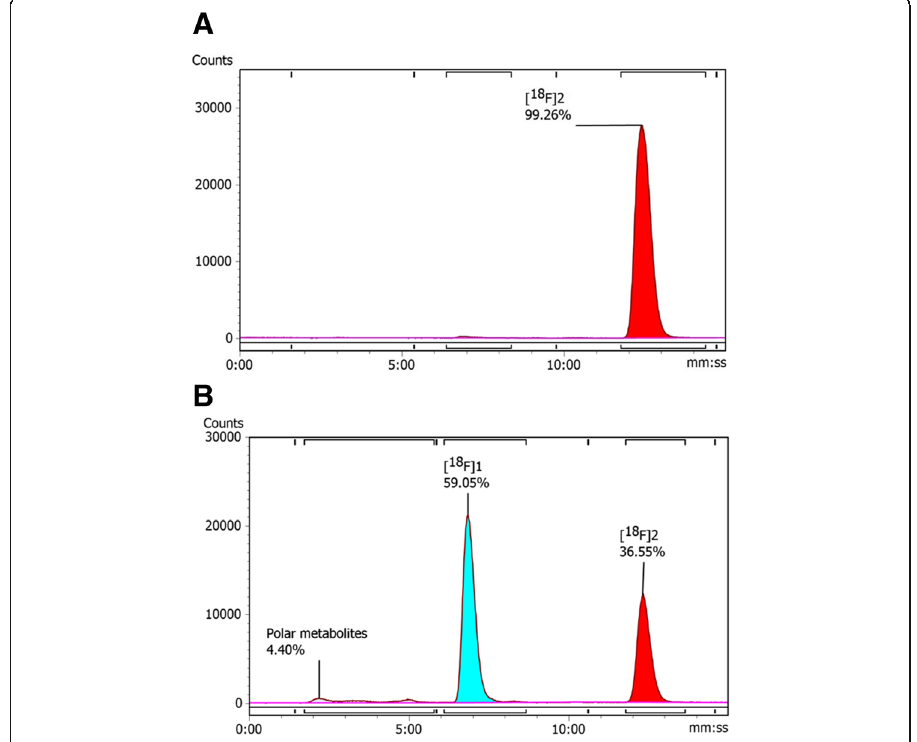
Fig. 6 Representative analytical RP-HPLC chromatograms of: a parent compound [ 18 F]2; b analysis after incubation of [ 18 F]2 with MLM for 60